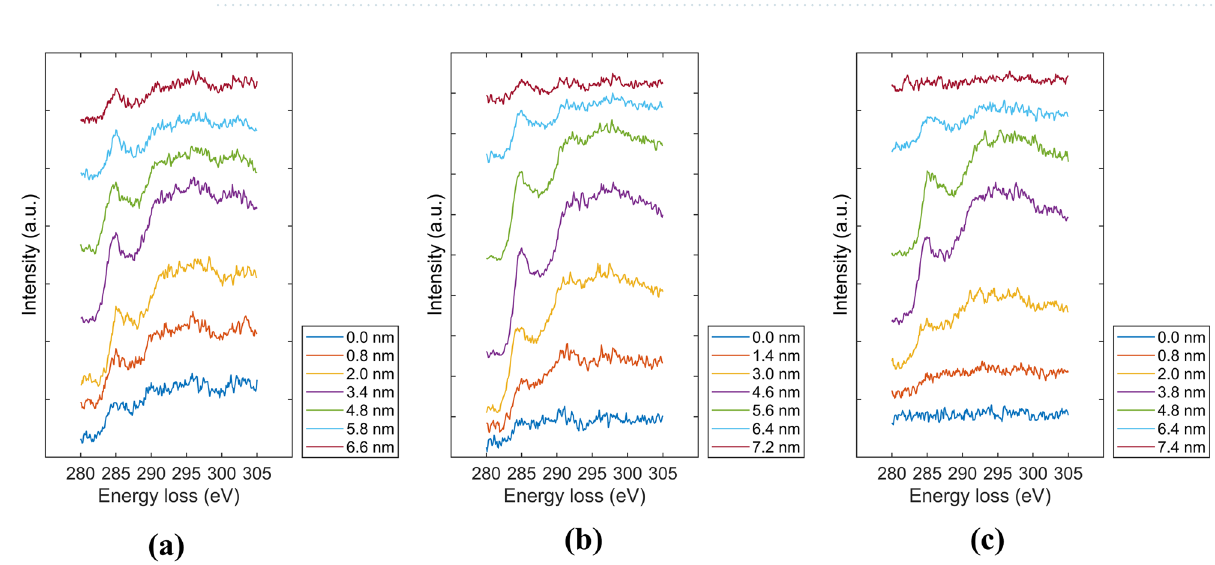
Figure 3. C K-edge EELS spectra of a -C/Si stacks: ( a ) untreated and ( b , c ) thermally annealed at 250 °C in Ar atmosphere for ( b ) 30 min and ( c ) 90 min. Representative spectra of the intermixing, bulk, and surface layers of the a -C film were obtained by advancing from the bottom spectra (blue color) of the Si substrate to the top spectra (dark red color) of the Cr capping layer in 0.2-nm the accurate estimation of the thicknesses of the individual layers comprising the a -C film and the total thick- ness of the a -C film and the SiN x underlayer. Specifically, the interface delineating the intermixing layer was assigned a normalized carbon intensity of < 0.15 in tandem with a sharply increasing sp 3 fraction, the interface of the intermixing layer with the bulk layer was determined by a normalized carbon intensity of 0.9–1.0 and afterward approximately constant sp 3 fraction, whereas the interface of the bulk layer with the surface layer was defined by a normalized carbon intensity of 0.85–0.95, followed by a sharp decrease of the sp 3 fraction. Finally, the interface between the surface layer and the capping layer was identified as the location having a normalized carbon intensity of 0.3–0.4 and very low and constant sp 3 fraction, attributed to adventitious carbon seeping into the matrix of the capping layer. Representative C K-edge EELS spectra of the untreated (as-fabricated) and thermally annealed a -C/Si and a -C/SiN x /Si stacks are respectively shown in Figs. 3 and 4. The collection of these